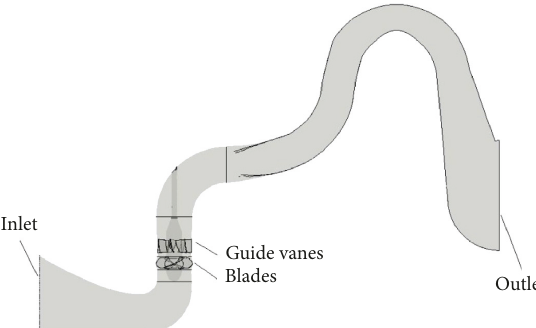
Figure 3: Computational domain of the pump.